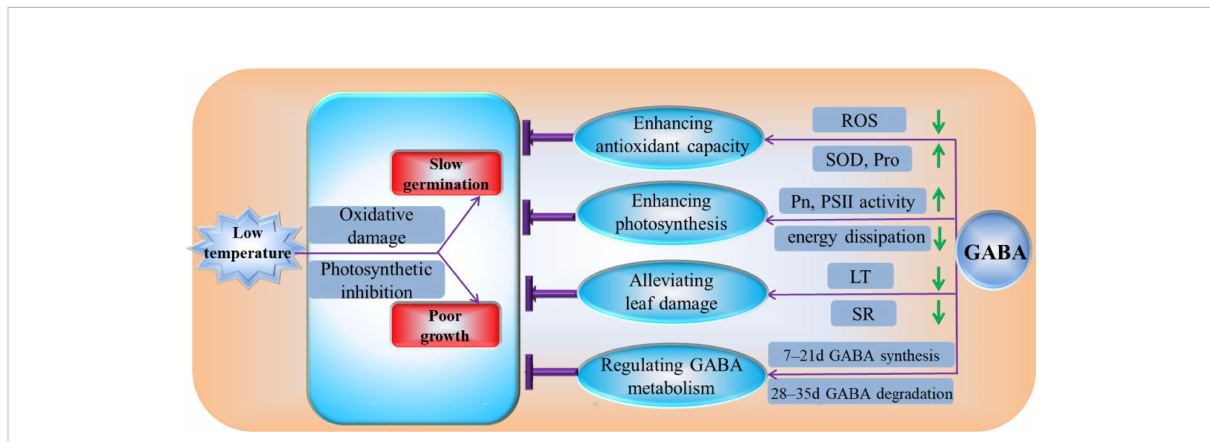
FIGURE 9 Physiological mechanism by which GABA regulates the cold tolerance of M. ruthenica under low-temperature conditions. ROS, reactive oxygen species; SOD, superoxide dismutase activity; Pro, the free proline; Pn, the net photosynthetic rate; PSII, photosystem II; LT, the thickness of leaf; SR, spongy ratio; GABA, g -aminobutyric